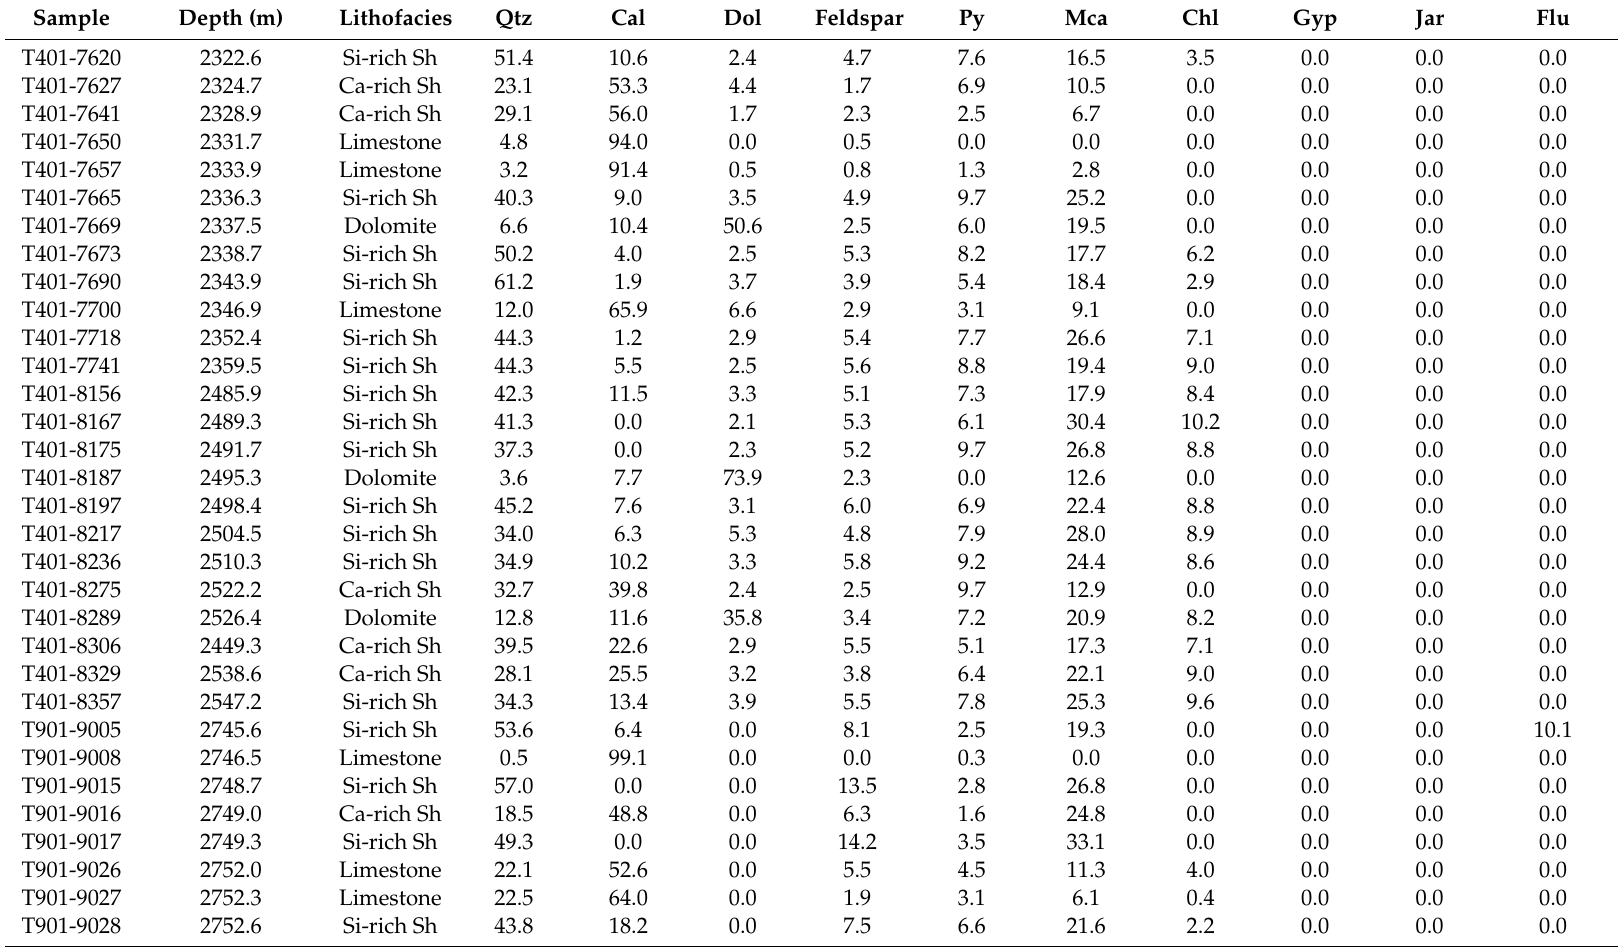
Table A1. Relative mineral abundances determined by RIR of analyzed samples from the Midland